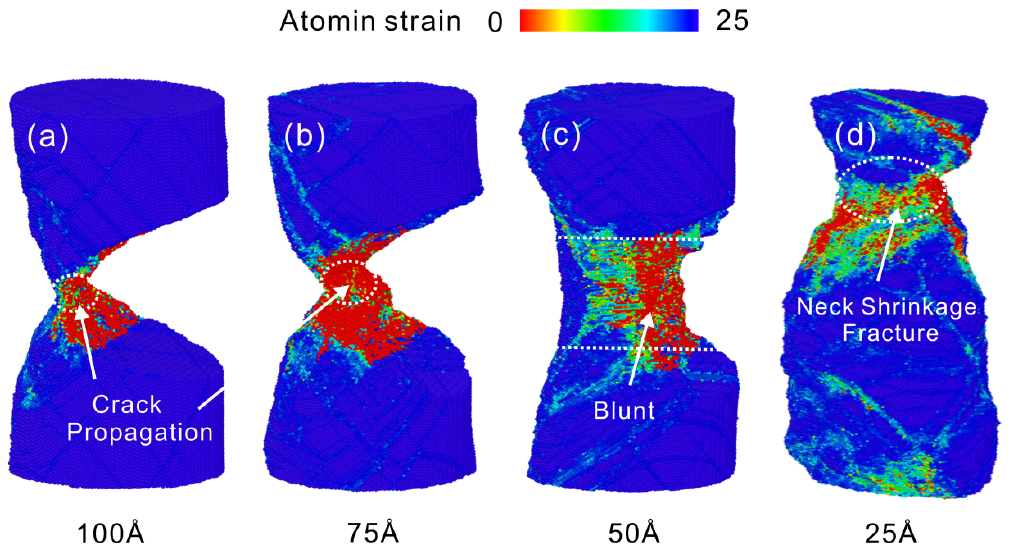
Figure 8. Atomic configuration for four depths of cracks at strain rate 5 × 10 9 s − 1 . ( a ) 100 Å, ( b ) 75 Å, ( c ) 50 Å, ( d ) 25 Å.